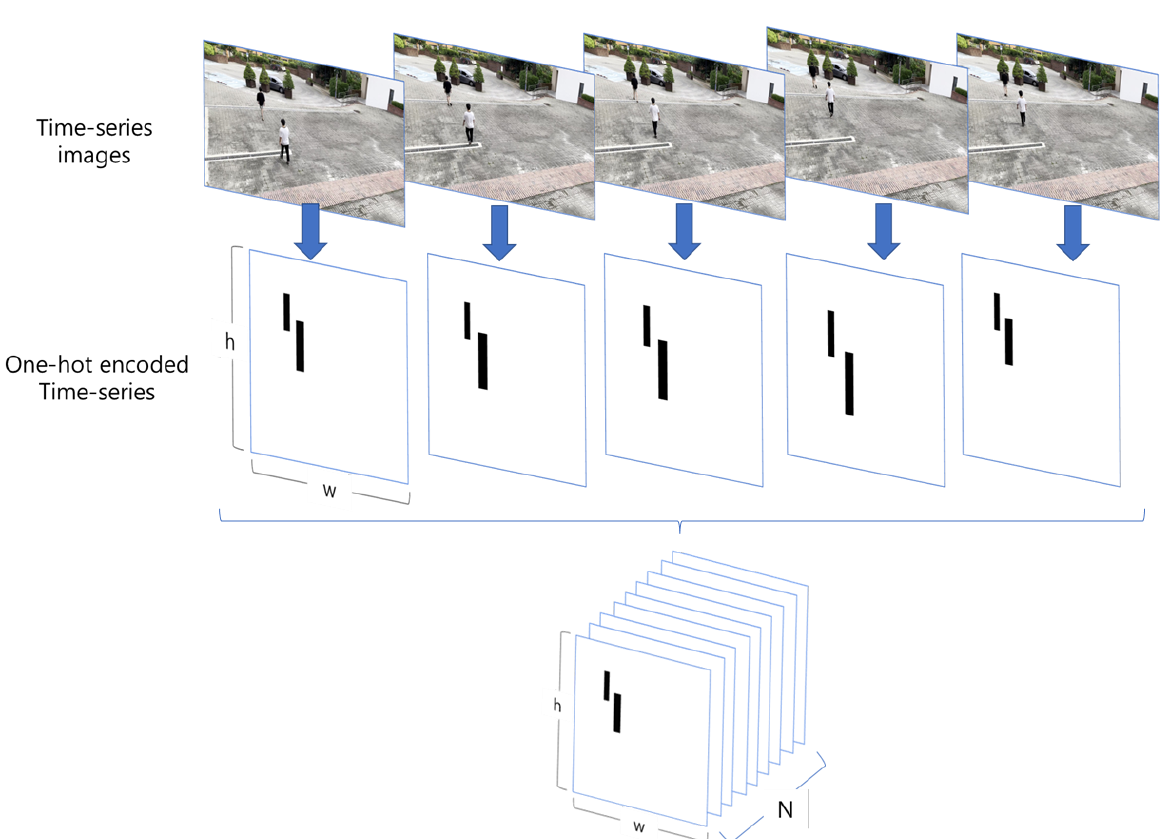
Figure 2. Pedestrian location information is encoded into a one-hot pattern; white regions represent the background, and black regions represent the bounding box surrounding each pedestrian. The encoded location information is concatenated along the time axis to form a 1 × N × H × W-dimensional